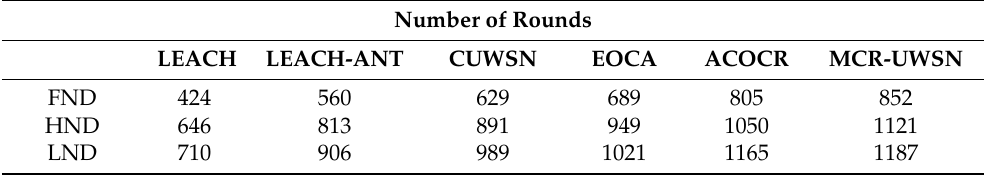
Table 1. Network lifetime analysis of the MCR-UWSN model with different measures.